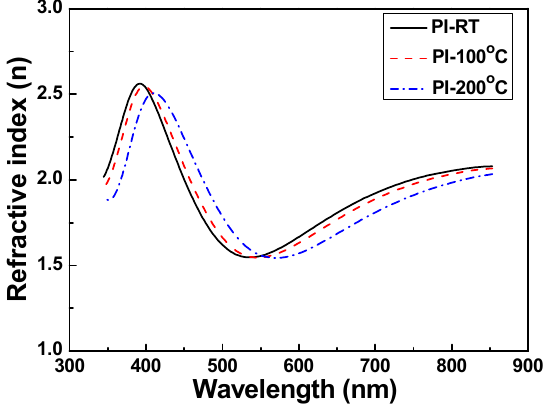
Figure 2. Refractive index of the GZO thin films as a function of deposition